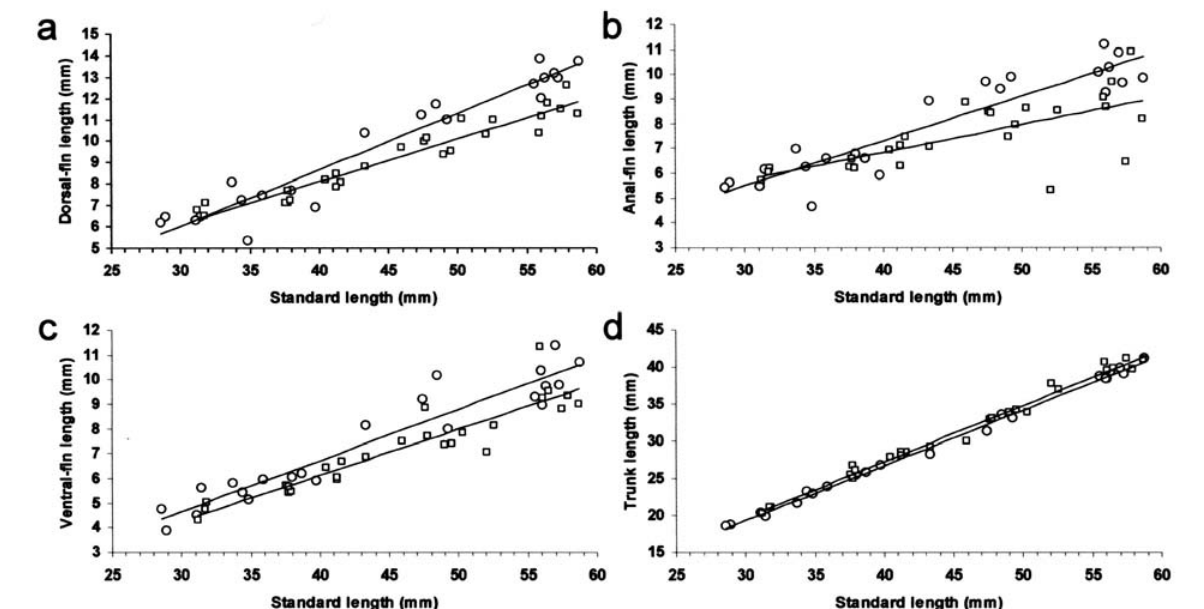
Fig. 5 . Biplots showing the distribution of data obtained for specimens of Pseudotocinclus juquiae (circles) and P. tietensis (squares).